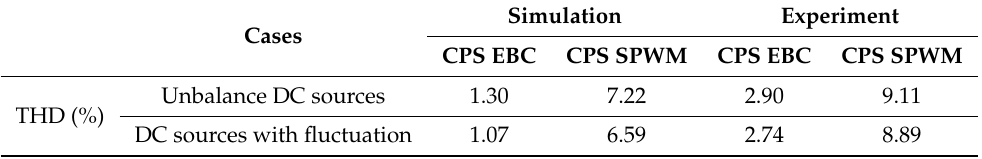
Figure 13. The comparison of the THD of the five-level simulation prototype under the case of DC voltages with fluctuations. ( a ) DC voltage u 1 contains a ripple with a frequency of 100 Hz and an amplitude of 16 V; and ( b ) DC voltage of each cascaded unit contains a frequency of 100 Hz and an amplitude of 8 V. Table 3. Simulation and Experimental results under DC voltages with